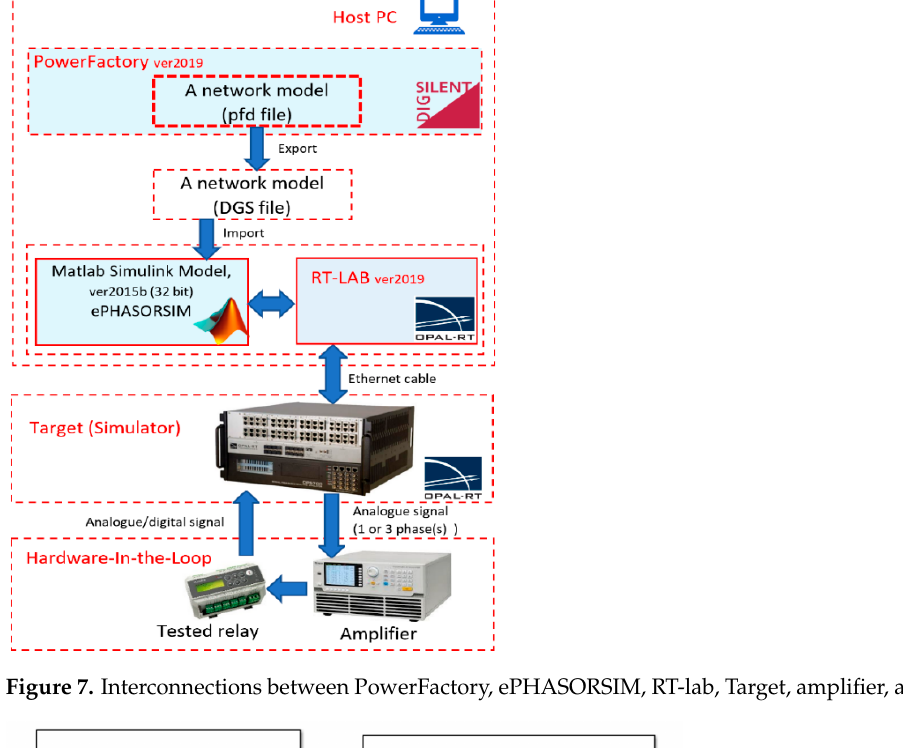
Figure 9. Simplified block diagram of the Simulink model including basic inputs/outputs.